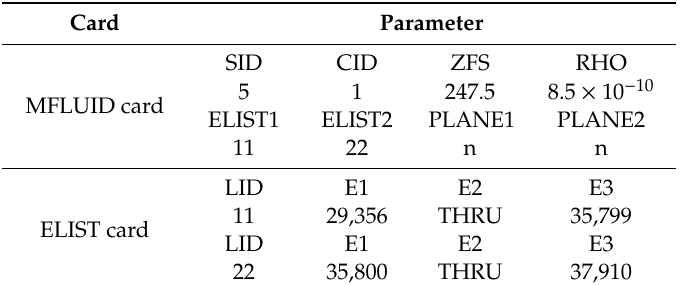
Table 1. Parameters of the MFLUID and ELIST control cards.